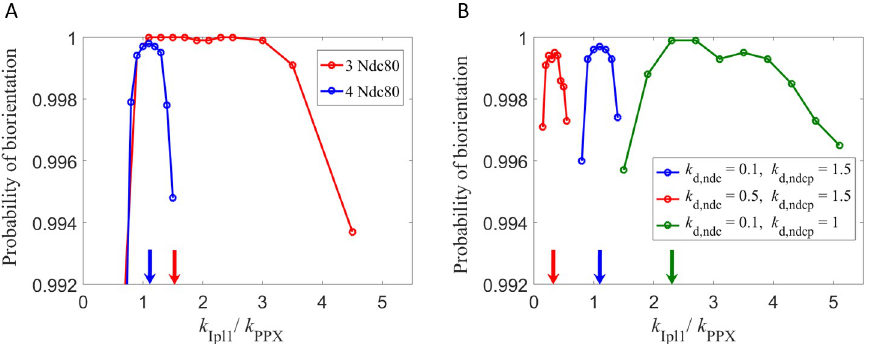
Fig 6. Analysis of the kinase-phosphatase balance point. Probability of sister KTs reaching biorientation within 10 min, starting from the syntelic attachment state. The location of the maximum in biorientation probability (balance point) is indicated with arrows. The value of phosphatase activity is set to k PPX = 1 s − 1 . (A) When the minimum number of Ndc80s needed to reach biorientation is lowered, the balance point occurs at higher values of k Ipl1 . For